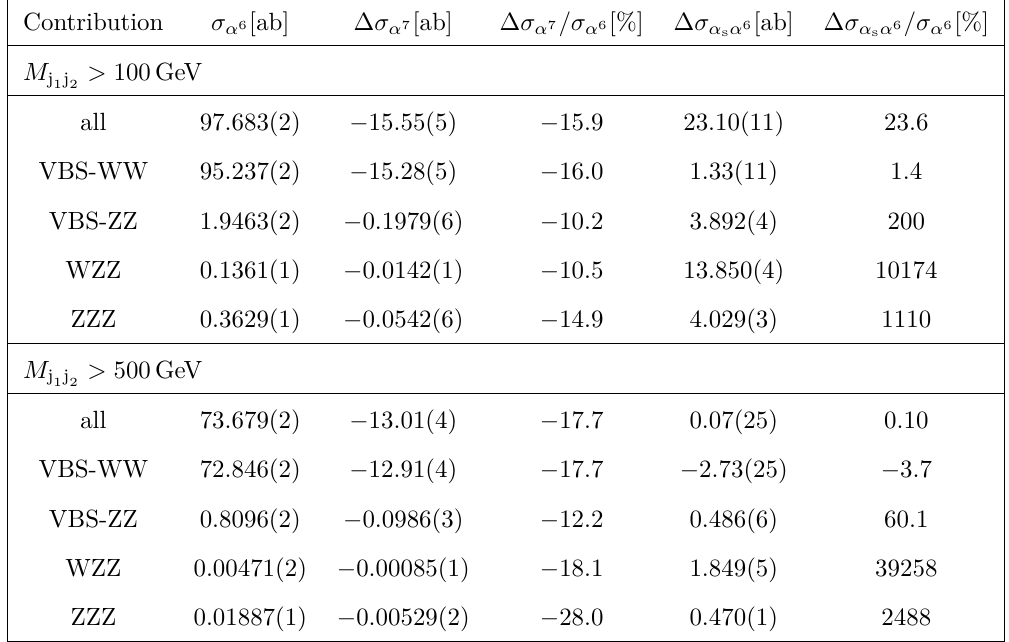
(cid:0) (cid:1) (cid:0) (cid:1) (cid:0) (cid:1) α 6 , O α 7 , and O α s α 6 are given in ab and (cid:0) (cid:1) α 6 cross section in percent. While the numbers in the upper part